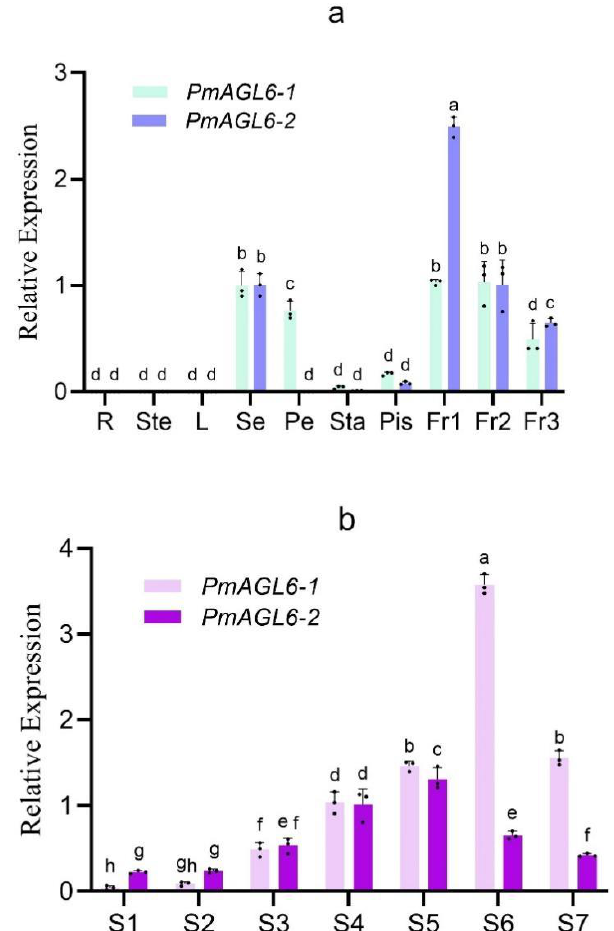
Figure 3. Expression patterns of PmAGL6-1 and PmAGL6-2 . ( a ) Expression patterns of PmAGL6-1 and PmAGL6-2 in different organs of P. mume . R: root, Ste: stem, L: leaf, Se: sepal, Pe: petal, Sta: stamen, Pis: pistile, Fr1–3: fruit development stages 1–3. ( b ) Expression patterns of PmAGL6-1 and PmAGL6-2 during P. mume floral bud differentiation. S1: flower primordium formation, S2: sepal initiation, S3: petal initiation, S4: stamen initiation, S5: pistil initiation, S6: ovule development, S7: anther development. Significant differences are identified by SPSS with Duncan’s test ( p < 0.05) and are represented by different letters above the error bars.